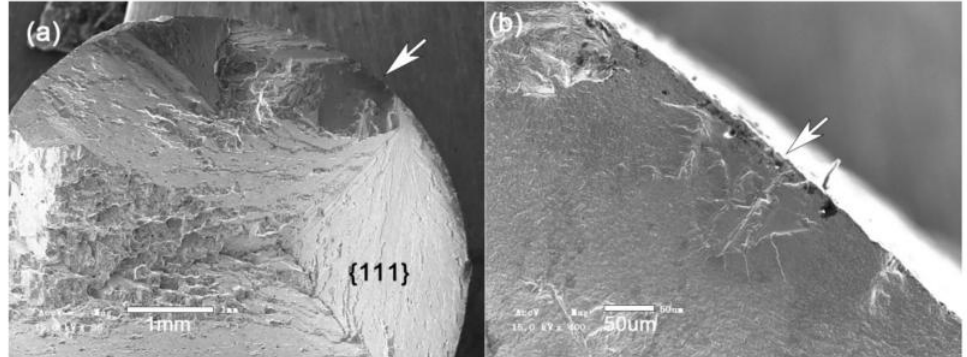
Figure 4. The original single crystal superalloy exhibited a crystallographic fracture mode at 550 ◦ C ( ε n = 0.7%, N f = 4889 cycles): ( a ) overall fracture surface; ( b ) crack initiation at casting porosity.